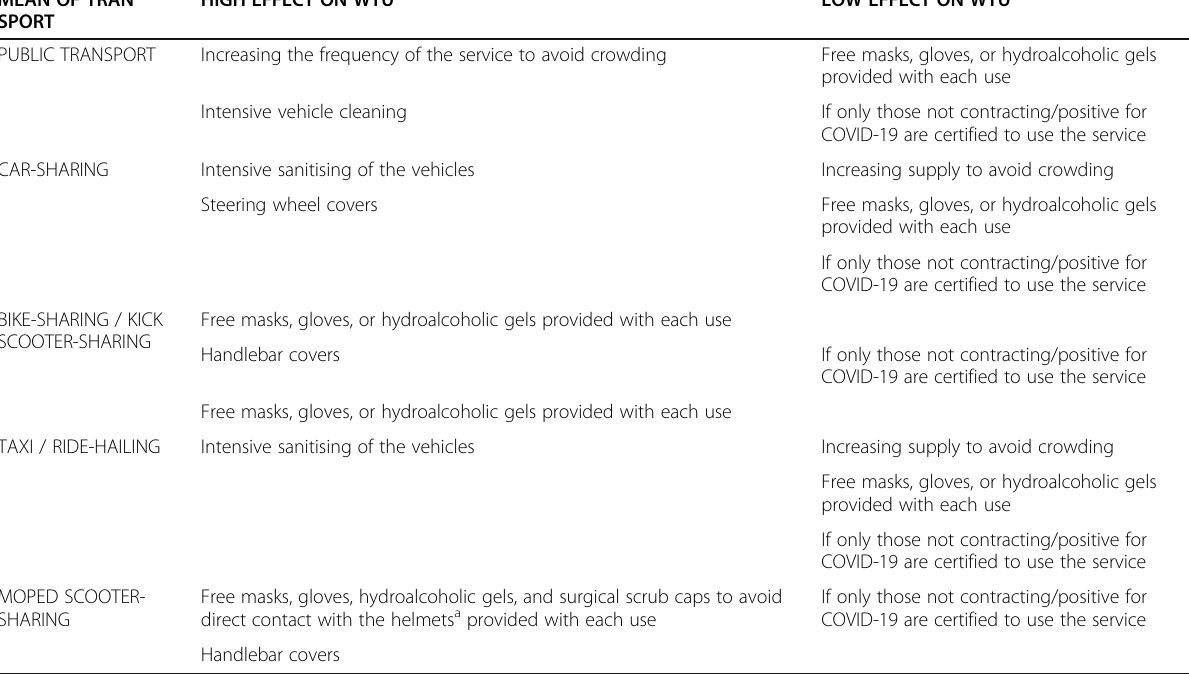
Table 6 Classification of measures according to their high/low effect on WTU MEAN OF TRAN